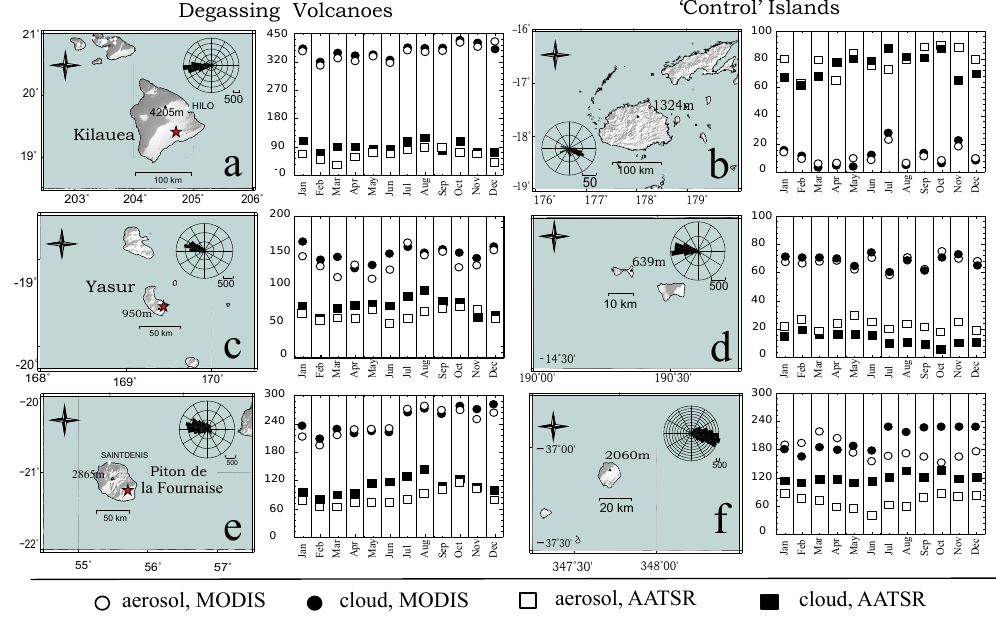
Figure 2. (a–f) Dimensions, topography and seasonal distribution of data sampling for each volcano and control island in the study. Wind roses show daily ECMWF wind directions, black bars indicate the directions towards which the wind was blowing. Locations of degassing vents are marked by red stars. Bar charts show the number of retrievals used in this study for each month of the year, Squares represent number of ENVISAT retrievals, circles, MODIS. Filled shapes are cloud and outlines are aerosol.